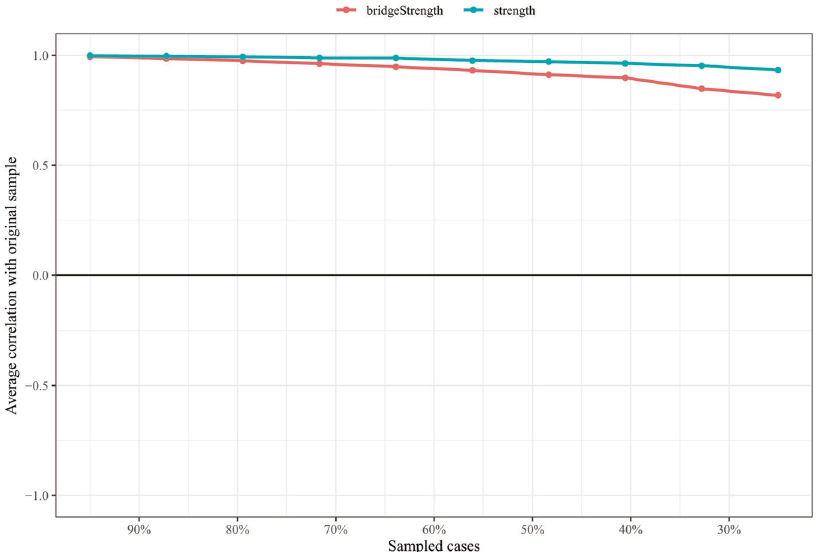
Fig. 3 The stability of strength and bridge strength using case-dropping bootstrap. The x-axis indicates the percentage of cases of the original sample included at each step. The y-axis indicates the average of correlations between the centrality indices from the original network and the centrality indices from the networks that were re-estimated after excluding increasing percentages of